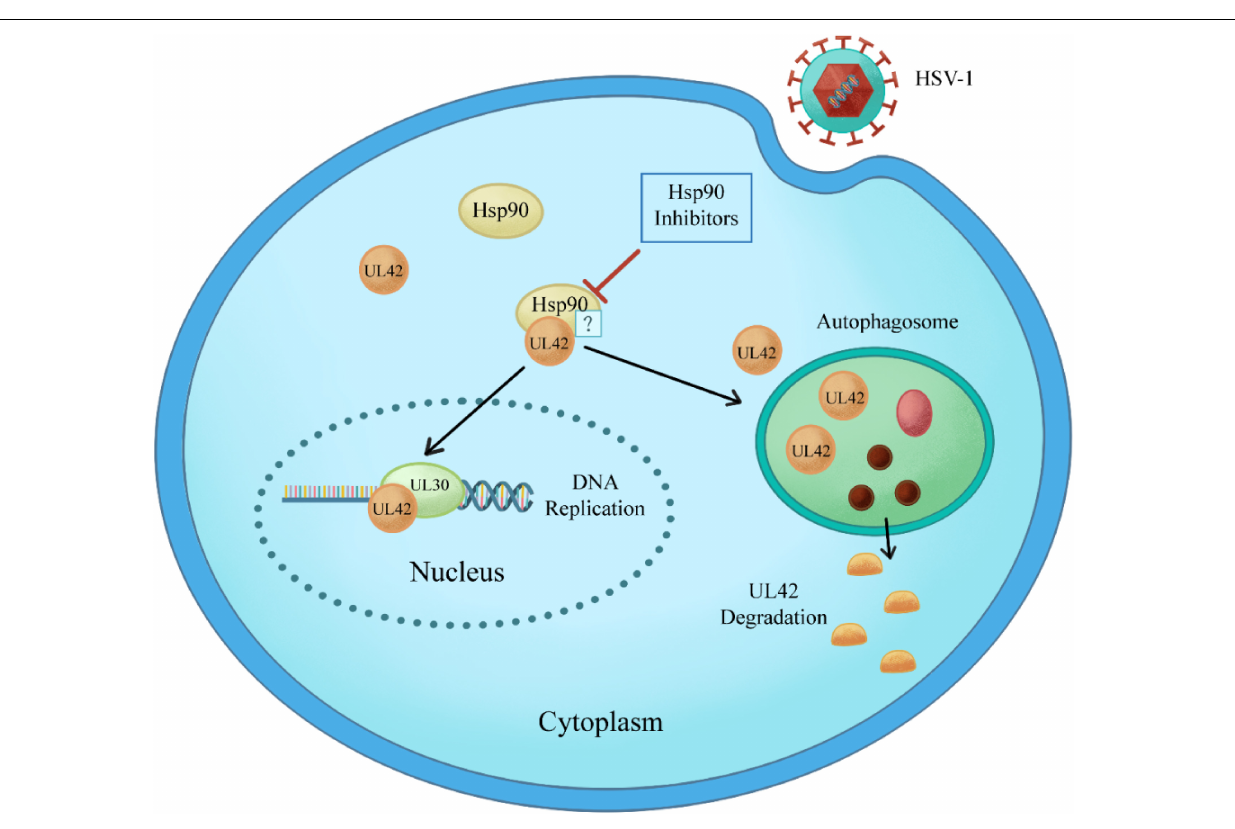
FIGURE 6 | Schematic model of Hsp90 inhibitors regulation of the interaction between Hsp90 and HSV-1 UL42. Specifically, Hsp90 inhibitors disrupt the interaction between Hsp90 and UL42, inducing the degradation in an autophagy-dependent